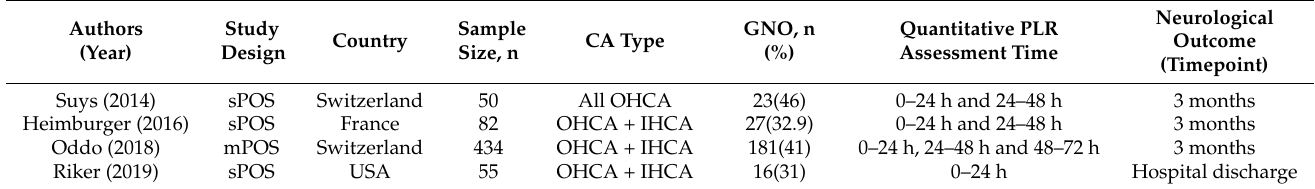
Table 1. Characteristics of included